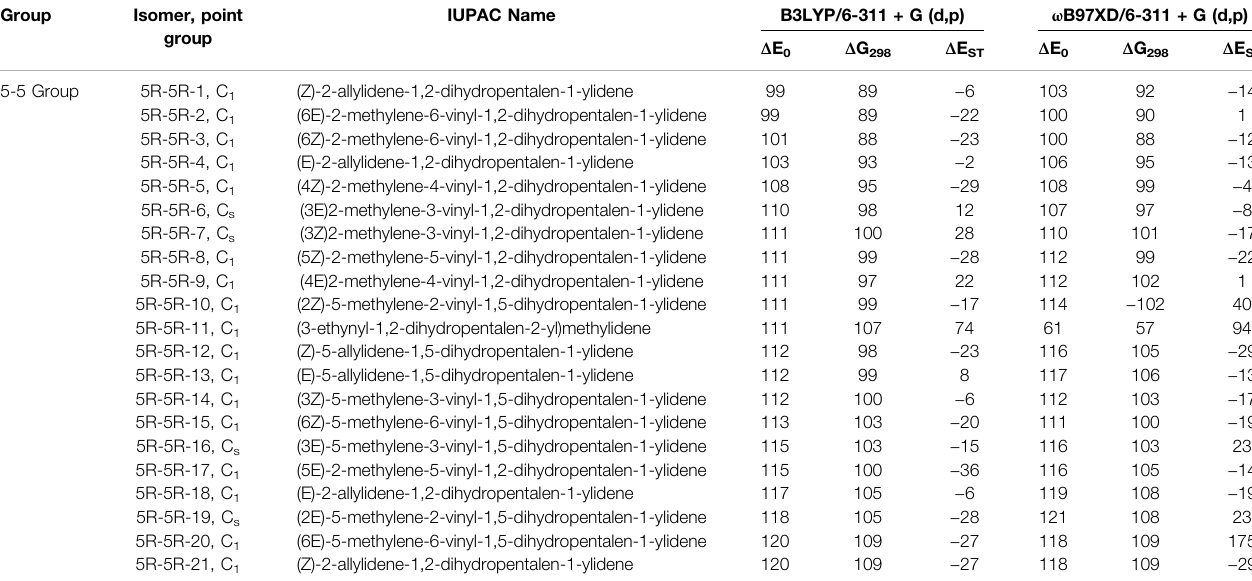
TABLE 4 | Same as Table 1 , low-lying C 11 H 8 isomer of (5R-5R) group with in ~120 kJ mol − 1 energy range calculated at different levels. Group Isomer, point group